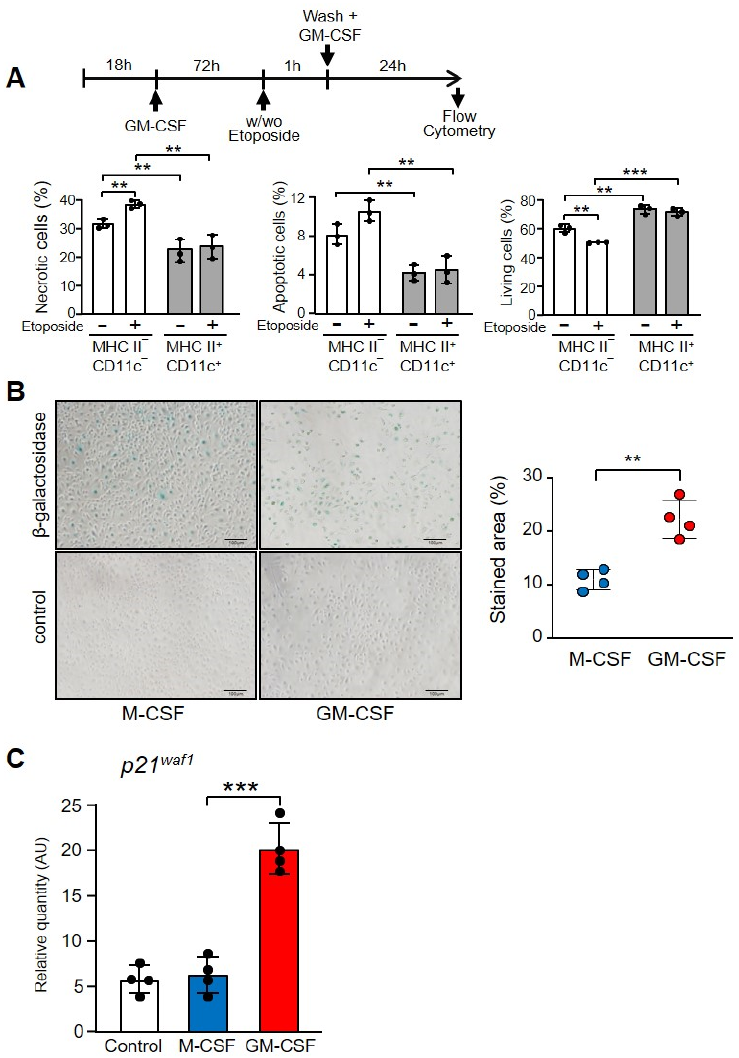
Figure 7. Differentiation markers of macrophages incubated with M-CSF or GM-CSF. ( A ) Necrotic, apoptotic or living cells in the population of macrophages treated with GM-CSF, comparing the phenotype MHC II − and CD11c − with MHC II + and CD11c + . The experimental design is shown at the top. Macrophages were cultivated in the presence of GM-CSF (10 ng/mL) for 72 h, then treated or not with etoposide for 1 h and, after washing, GM-CSF (10 ng/mL) was added for 24 h. An example of quantification is shown in Supplementary Materials Figure S5. Gating was conducted using antibodies to CD11c and MHC II with the corresponding controls. Then, the double positive and negative cells were gated and DAPI and Annexin V staining was determined ( n = 3). ( B ) Macrophages were incubated with M-CSF or GM-CSF for 24 h and then stained for senescence- associated β -galactosidase staining. On the left is an example of staining. The control was unstained cells. The right panel shows the quantification of four independent experiments. ( C ) Macrophages were cultured in the presence of M-CSF or GM-CSF for 72 h. Gene expression was analyzed by real-time PCR ( n = 3). Each experiment was performed in triplicate, and the results are shown as the mean ± SD. ** p < 0.01 and *** p < 0.001 in relation to the corresponding phenotypes or treatments with M-CSF or GM-CSF, when all the independent experiments had been compared. Data were analyzed using Student’s t -test.